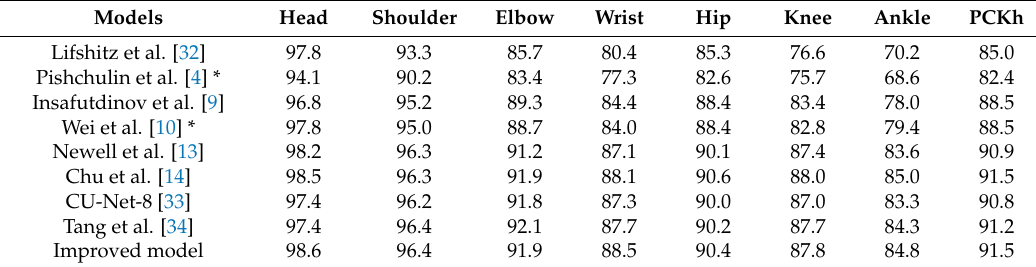
Table 9. The accuracy of the nine